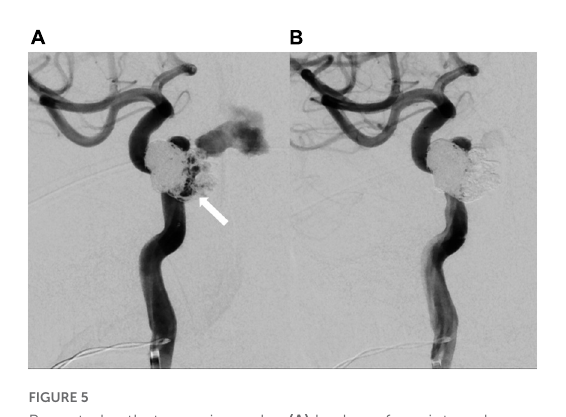
FIGURE5 Repeated catheter angiography. (A) Leakage from internal carotid artery (white arrow) was observed. (B) No more leakage after repeated coil embolization.